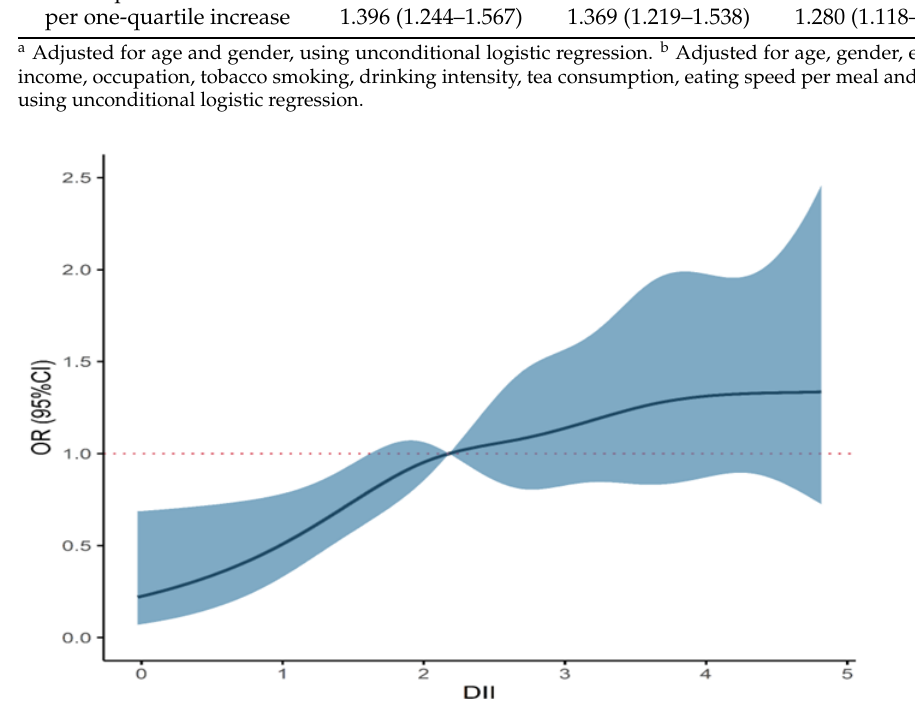
Figure 6. Restricted cubic spline curve fitting the relationship between DII and the risk of esophageal squamous cell cancer adjusting for age, gender, education, income, occupation, tobacco smoking, drinking intensity, tea consumption, eating speed per meal and hot food. The red dotted line stands for the reference level. The solid black line represents the OR, and the shaded part the lower and upper 95% CI; P overall < 0.001; P nonlinear < 0.001. Abbreviation: DII, dietary inflammatory